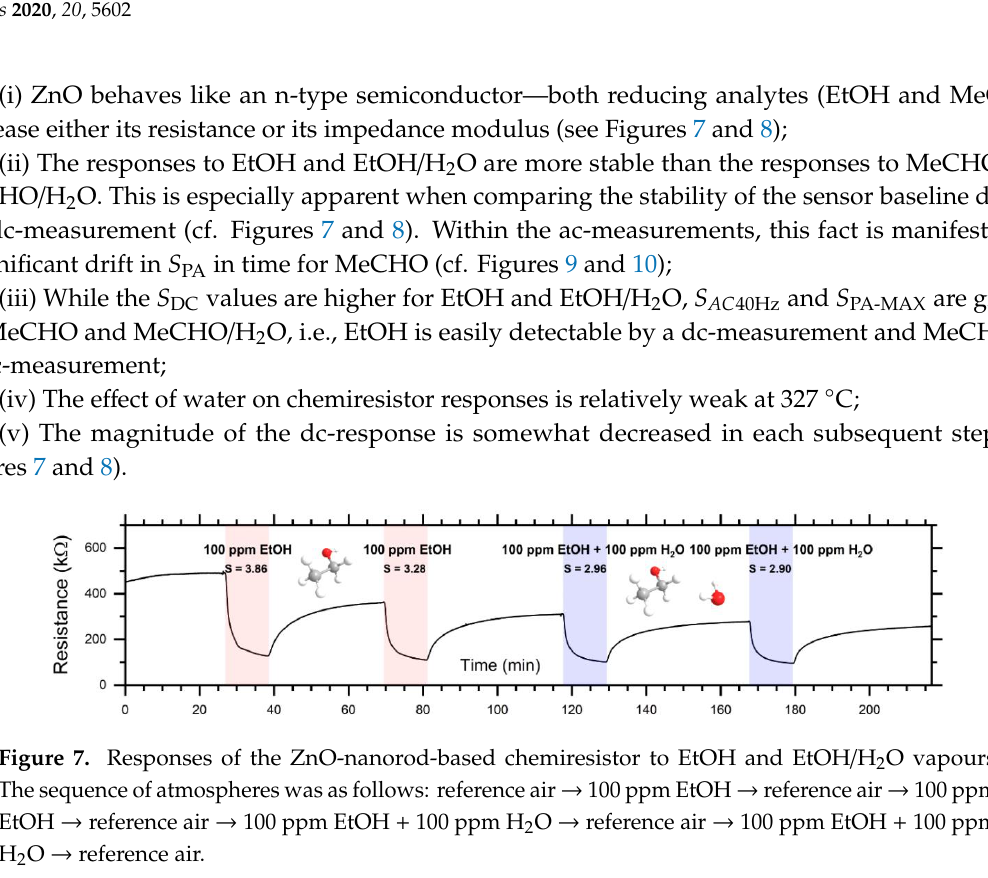
( a ) ( b ) Figure 10. The dependence of phase-angle response vs. frequency for 100 ppm MeCHO ( left ); 100 ppm MeCHO + 100 ppm H 2 O ( right ). The reference atmosphere was synthetic air. Table 1. Detection parameters of ZnO-nanorod based chemiresistors: dc-response ( S DC ); ac-response at 40 Hz ( S AC 40Hz ); maximum phase-angle response S PA-MAX and the corresponding frequency of the measuring signal. The reference atmosphere was synthetic air in all cases. Dc-Parameter